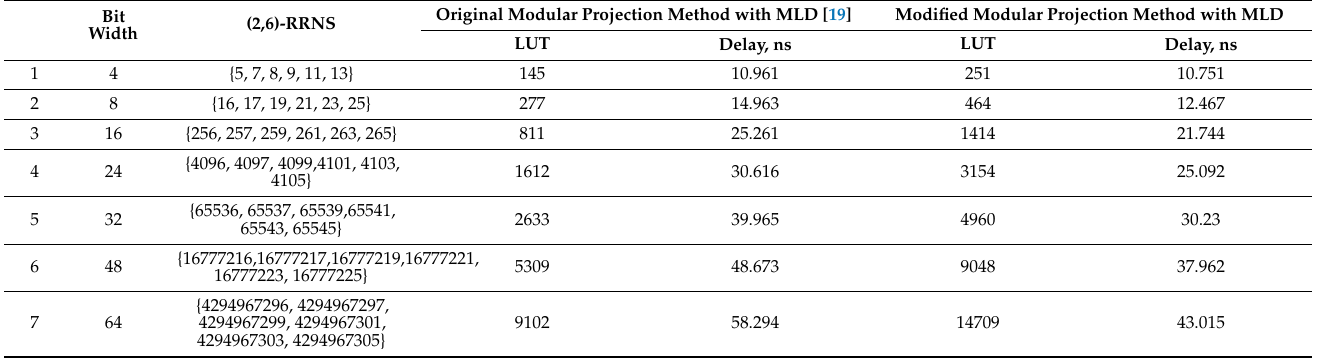
Table A8. Hardware and time costs for correcting double errors and restoring numbers in